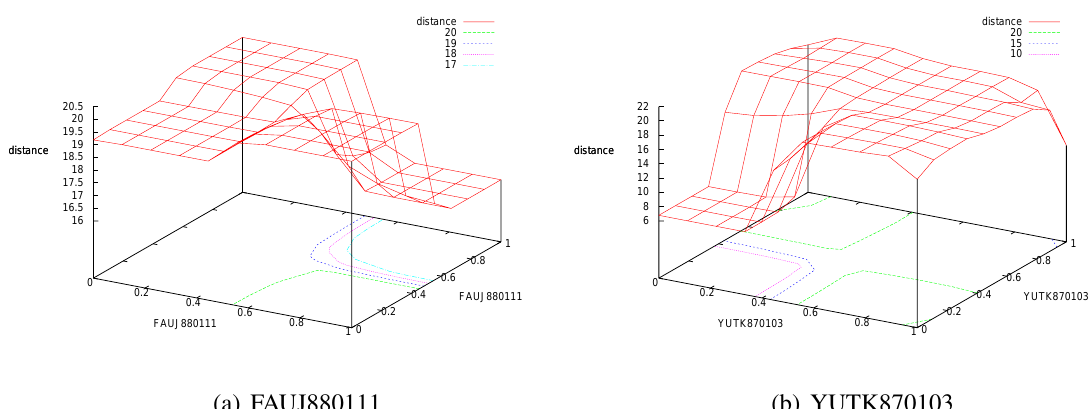
Figure 5: Pattern type: “stepped surfaces”. The 3D surface represents the mean distances among pairs of amino acids according to properties (a) FAUJ880111 and (b) YUTK870103.